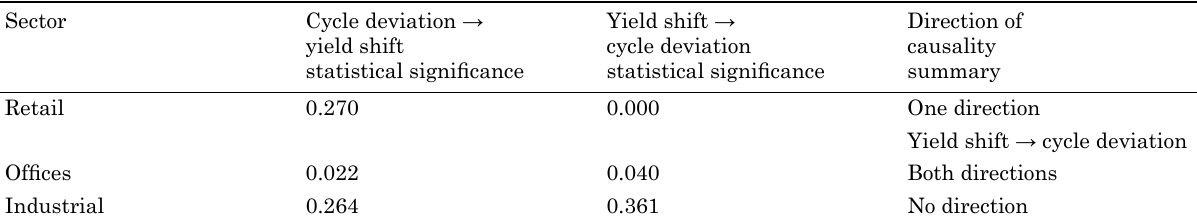
Table 2. Results of granger causality tests between yield changes and deviation in sales from HP trends for each